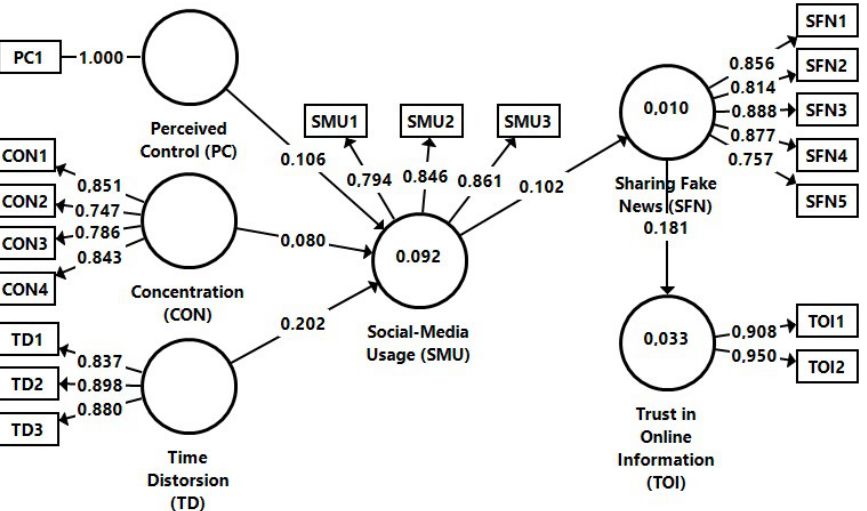
Figure 2. Structural model: Prerequisites of Trust in Online Information about Companies. Source: own development in SmartPLS based on the collected data .